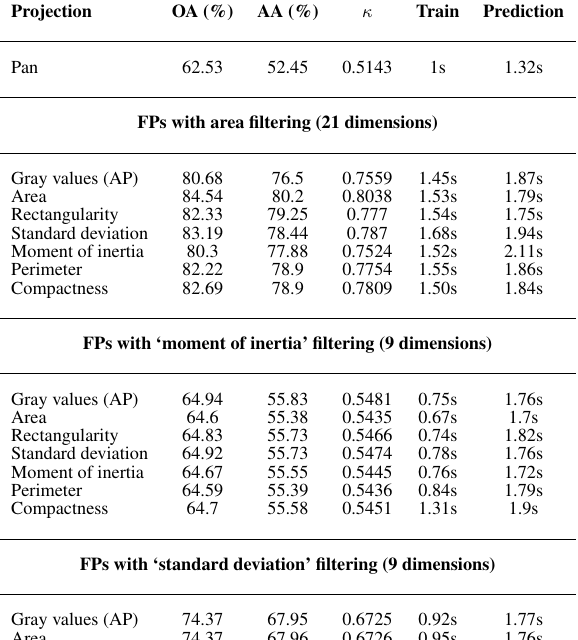
Table 2. Scores and execution times of the classification of the Reykjavik data using APs and FPs.